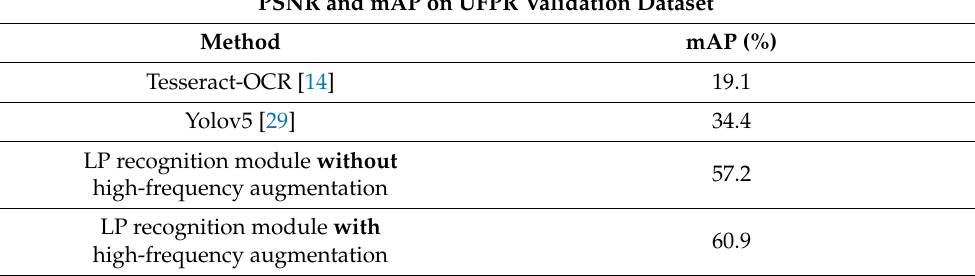
Figure 14. LP recognition results on same SR result (80 × 60). ( a ) Tesseract-OCR result, ( b ) OpenALPR result ( c ) Yolov5 result, ( d ) HIFA-LPR result, ( e ) HR image. “_” denotes a missing character. Red character denotes an incorrect prediction. Blue character denotes a correct prediction. “GT” denotes ground truth. “Pred” denotes the prediction result. Table 6. Comparison between the LP recognition module based on high-frequency augmentation and other modules for scale factor ( × 4) on the UFPR